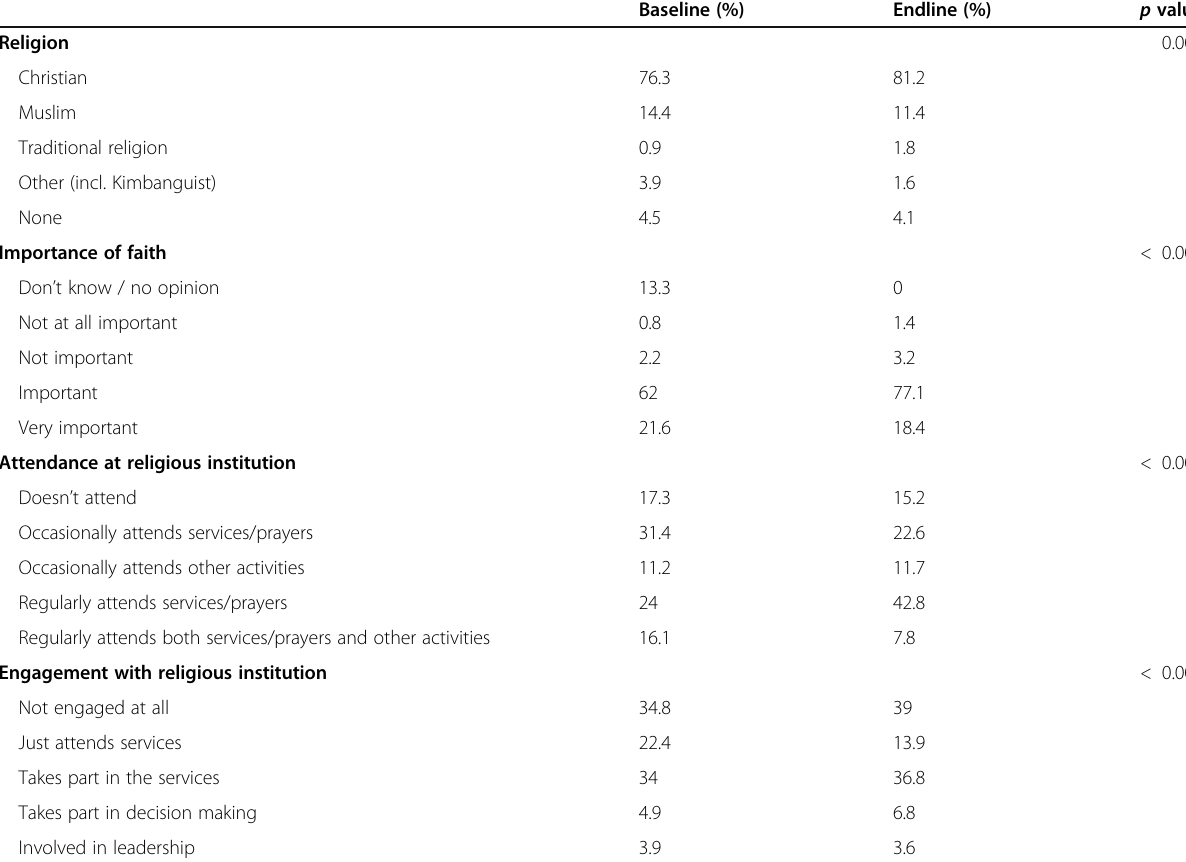
Table 6 Religious and faith participation and